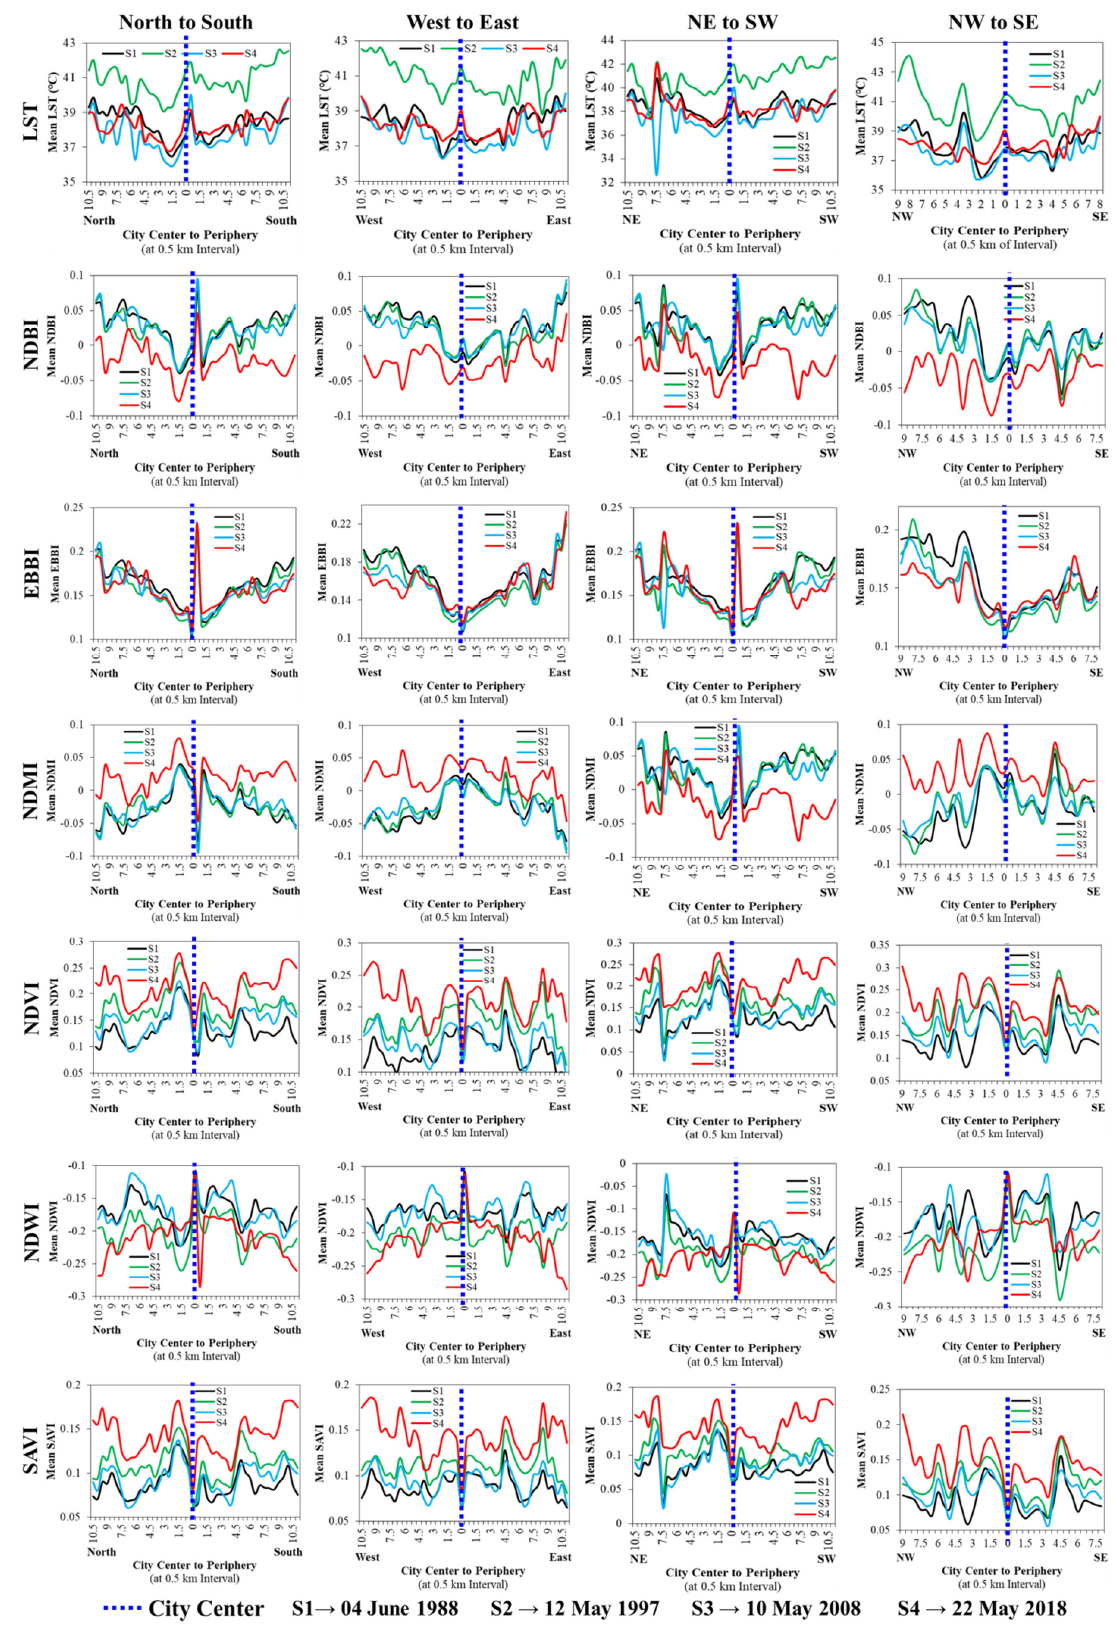
Figure 15. Effects of the land indices on the distribution of LST dynamics in the summer season in Prayagraj city (1988–2018).